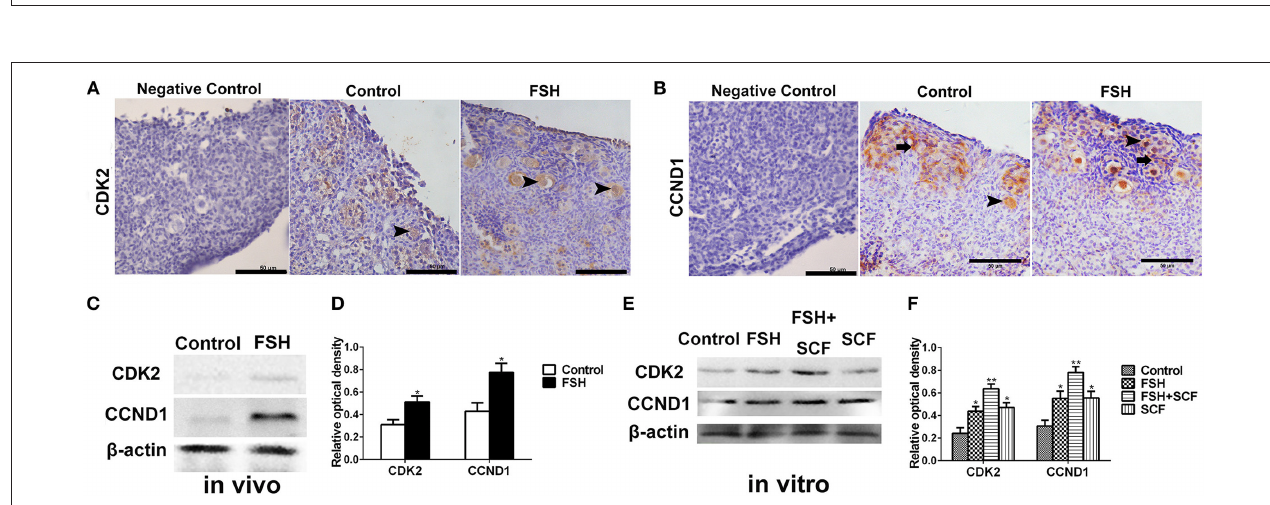
FIGURE 8 | Combined effects of FSH and SCF on the expressions of cell cycling proteins CCND1 and CDK2. (A–D) 4-day-old chickens were treated by FSH in vivo . Brown staining represents the immunohistochemical antigen. (E,F) 4-day-old chicken ovaries were treated by FSH or SCF for 2 days in vitro . (A) Arrowheads represent oocytes stained with CDK2 antibody. (B) Arrowheads and arrows represent oocytes and somatic cells stained with CCND1 antibody. (C,D) Western blot and gray analysis indicate that FSH promoted the CDK2 and CCND1 protein expression in vivo . (E,F) Western blot and gray analysis indicate that SCF enhanced the effect of FSH on promoting the CDK2 and CCND1 protein expression in vitro . T -tests were used to determine statistically significant differences. The values are the mean ± SEM of six experiments. Asterisks indicate significant differences (* P < 0.05, ** P < 0.01). Scale bars: 50 µ m.